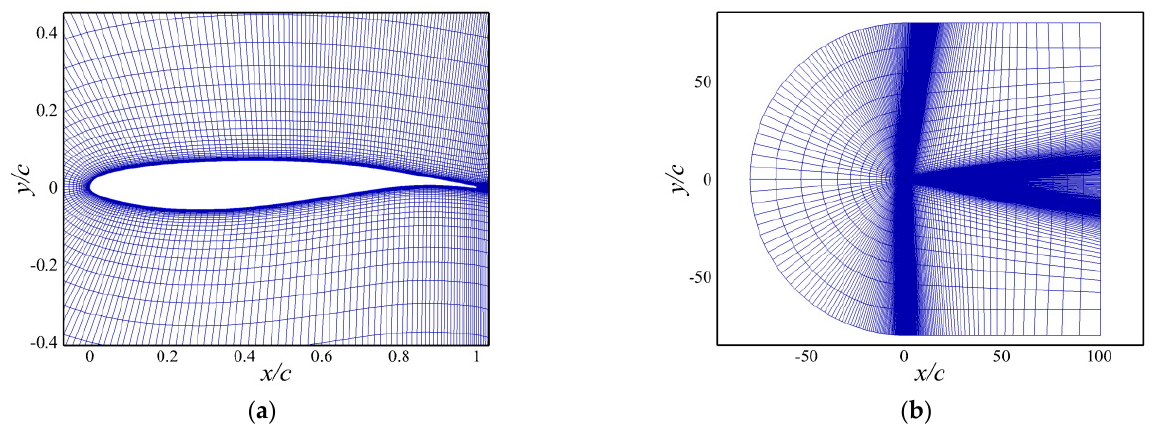
Figure 3. Computational grid. ( a ) Near wall grid. ( b ) Far-field grid. Table 1. The details of the computational grids.